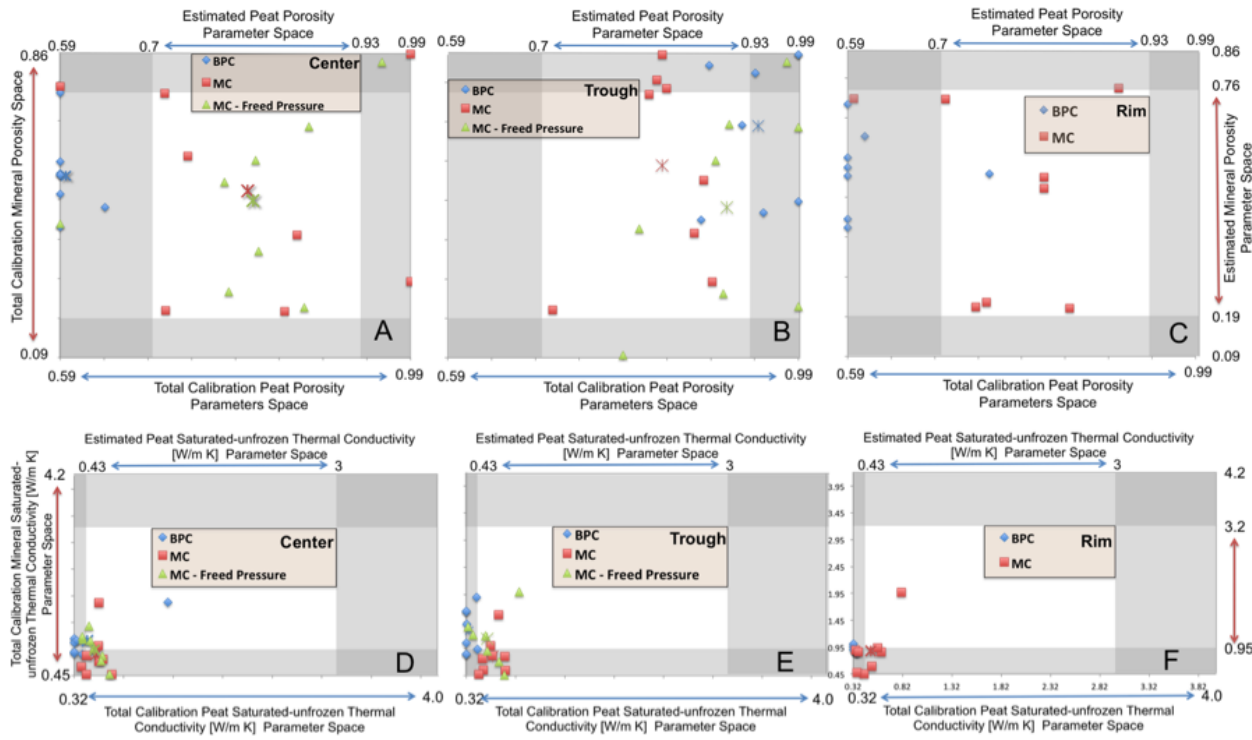
Figure 5. Panels (a) , (b) and (c) show center, trough and rim, respectively, calibrated peat and mineral porosities from eight calibrations starts. Panels (d) , (e) and (f) show calibrated saturated unfrozen thermal conductivities ( K sat , uf ) for peat and mineral soil layers from the same eight calibrations starts. K sat , uf values from the MC calibration are calculated from Eq. (3). Blue diamonds used the BPC model for soil thermal conductivity, red squares used the MC model for soil thermal conductivity, and green triangles added surface pressures as a free calibration parameter to the MC model for soil thermal conductivity. Color-coded asterisks represent the average calibrated parameter for each model tested for the eight calibration starts, but are not actual calibrated results. Accepted parameter space delineated from literature and site observations in all cases are mapped as clear areas. Shaded areas are the calibration space outside of the acceptable parameter space. This figure shows how the calibration response surface changes as the model changed from (1) BPC to (2) MC to (3) unsaturated. Table 2. The calibration error from the measured values reported as the RMSE ◦ C (phi) increased between the (1) BPC model to the (2) MC saturated model. Thus there was greater error in the model results, but the calibrated parameters were more realistic. Phi then decreased between the (2) MC saturated model and (3) the MC unsaturated model. BPC MC MC – freed